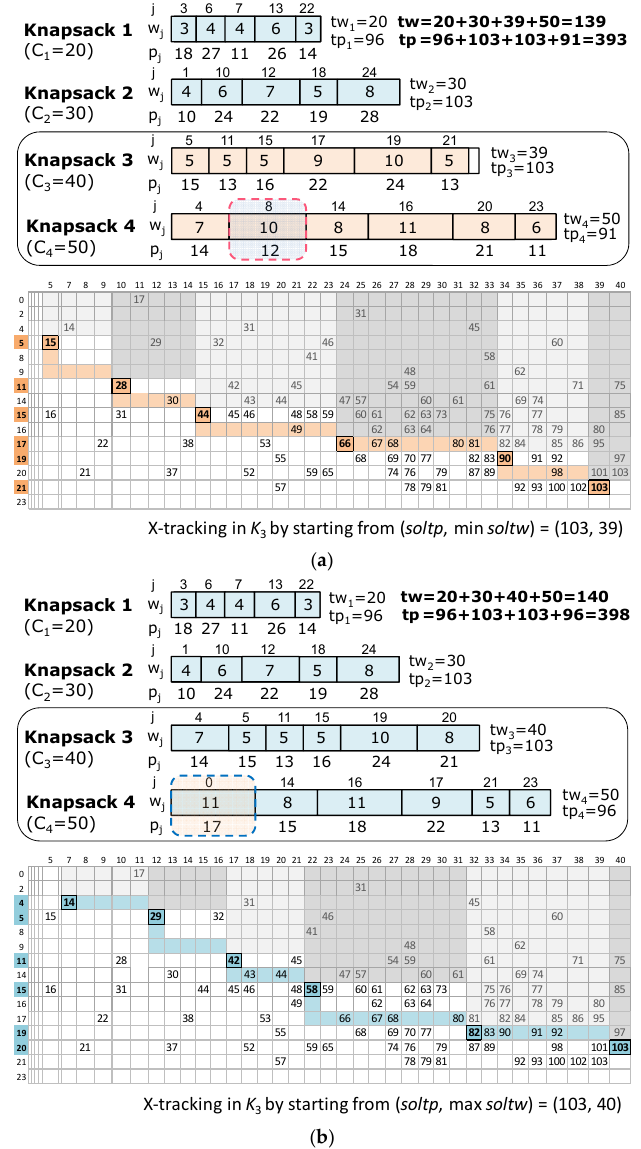
Figure 10. An example ( n = 25, m = 4, C = (20, 30, 40, 50)) of two X-tracking with nonunique solution Xs in K 3 : ( a ) start tracking from ( soltp , min soltw ) and ( b ) start tracking from ( soltp , max soltw ). Algorithm 9: Multi-DPT-List TSR for one proper order: O( m [ n 2 , nC ]).